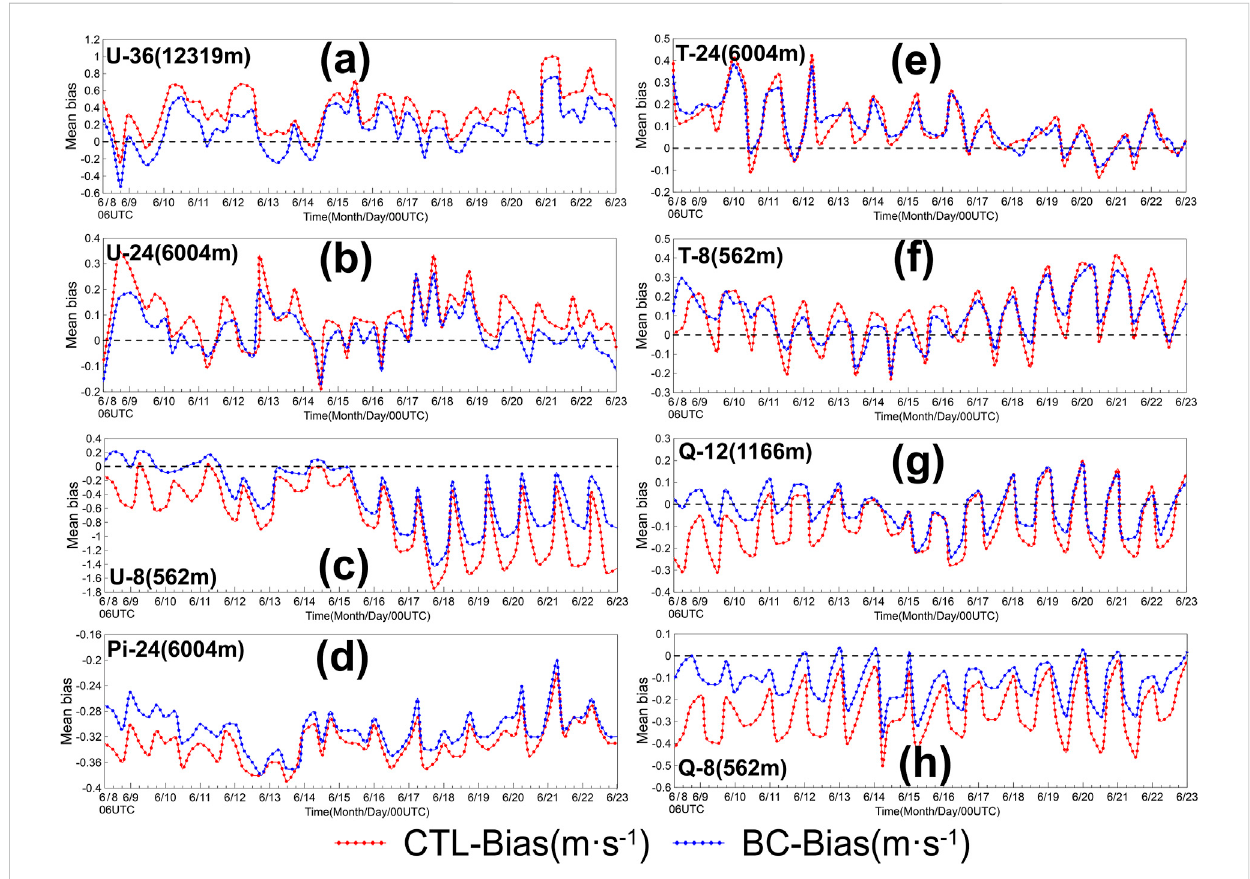
FIGURE 8 Evolutionofthemeanbias(dottedline)overtimefortheU,T,Pi,andQvaluesatdifferentmodellayers. (A) Uin36-layer, (B) Uin24-layer, (C) Uin8- layer, (D) Pi in 24-layer, (E) T in 24-layer, (F) T in 8-layer, (G) Q in 12-layer, and (H) Q in 8-layer (initialized at 0000, 0600, 1200, and 1800 UTC every day, with a forecast of 6 h, from 8 to 23 June 2022) (Pi and Q are multiplied by